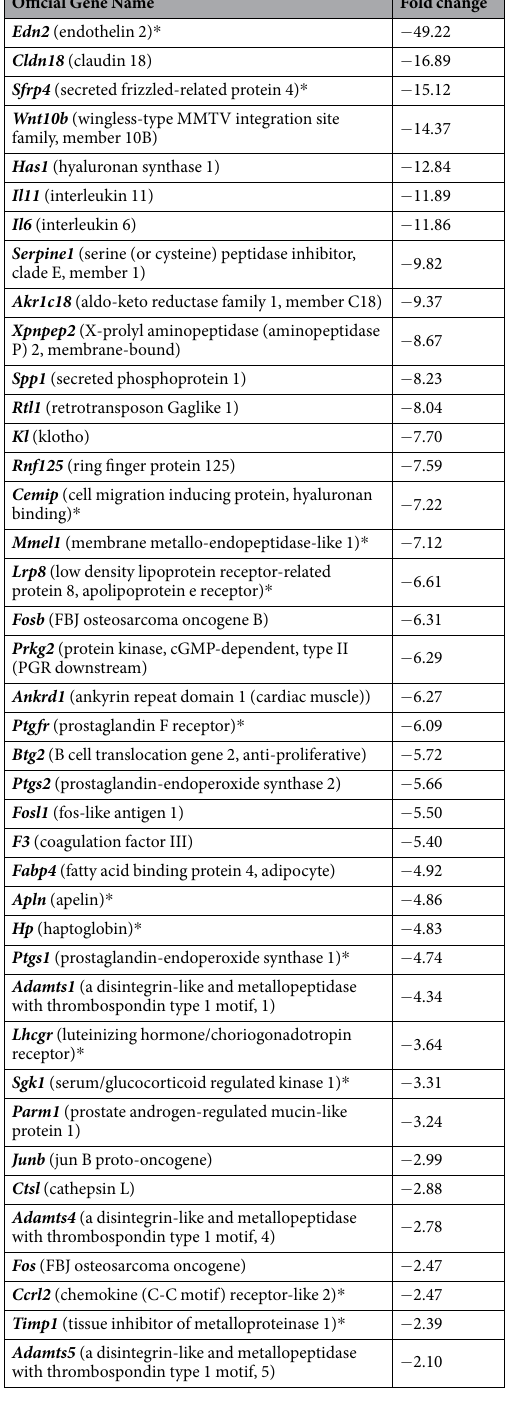
Table 1. A list of selected down-regulated genes in gcRunx2;CbfbKO